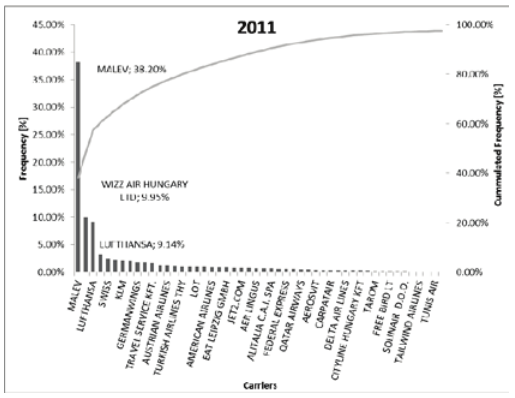
fig. 7. Market share of carriers at Liszt Ferenc Airport (BUD) (Source: own edition based on Hungaro Control Data) After having seen that the LCCs have significantly raised their market share at Liszt Ferenc Airport (BUD), the authors investigated the LCC-related planes and pas- sengers (Fig. 8).